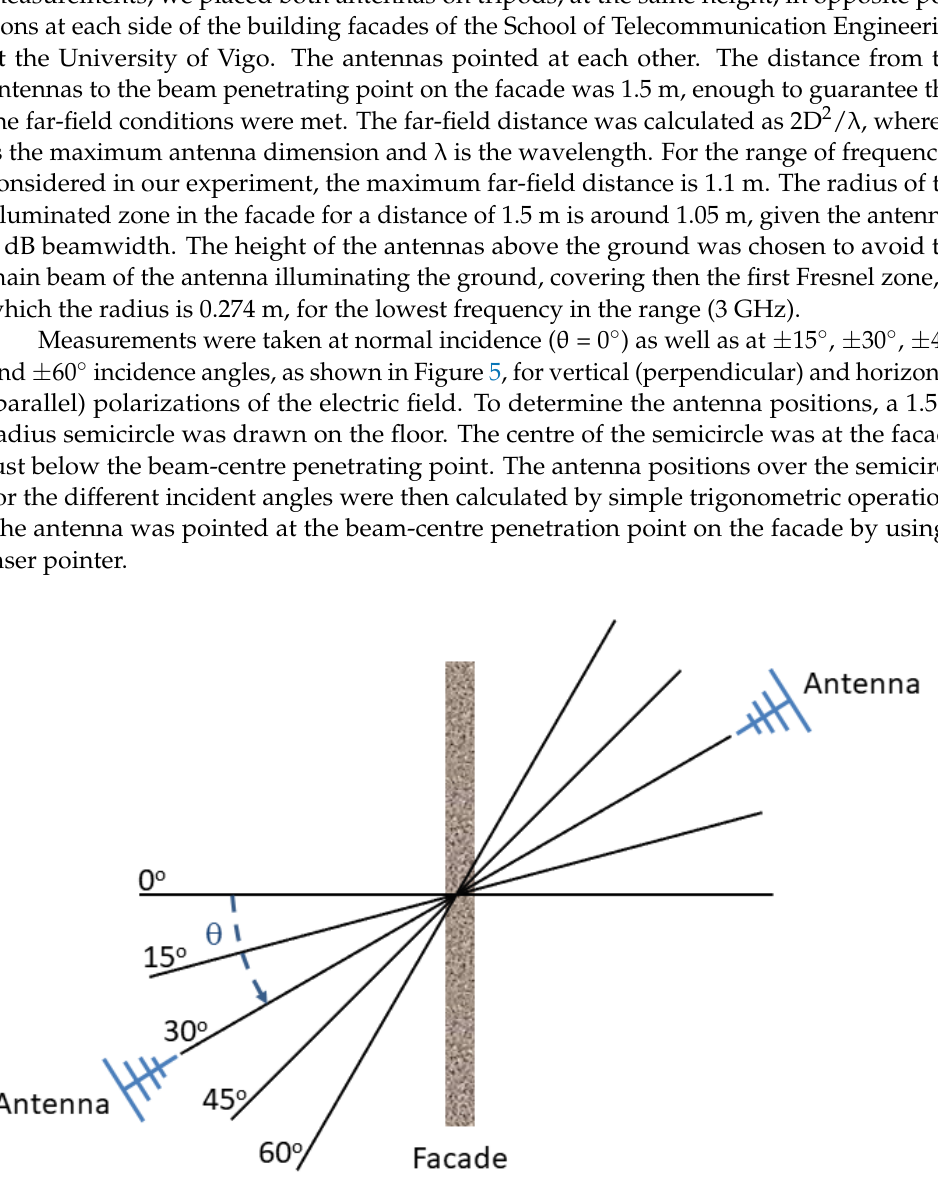
Figure 5. Schematic representation of measurement procedure, with the antennas configured to 30° incidence angle measurements.